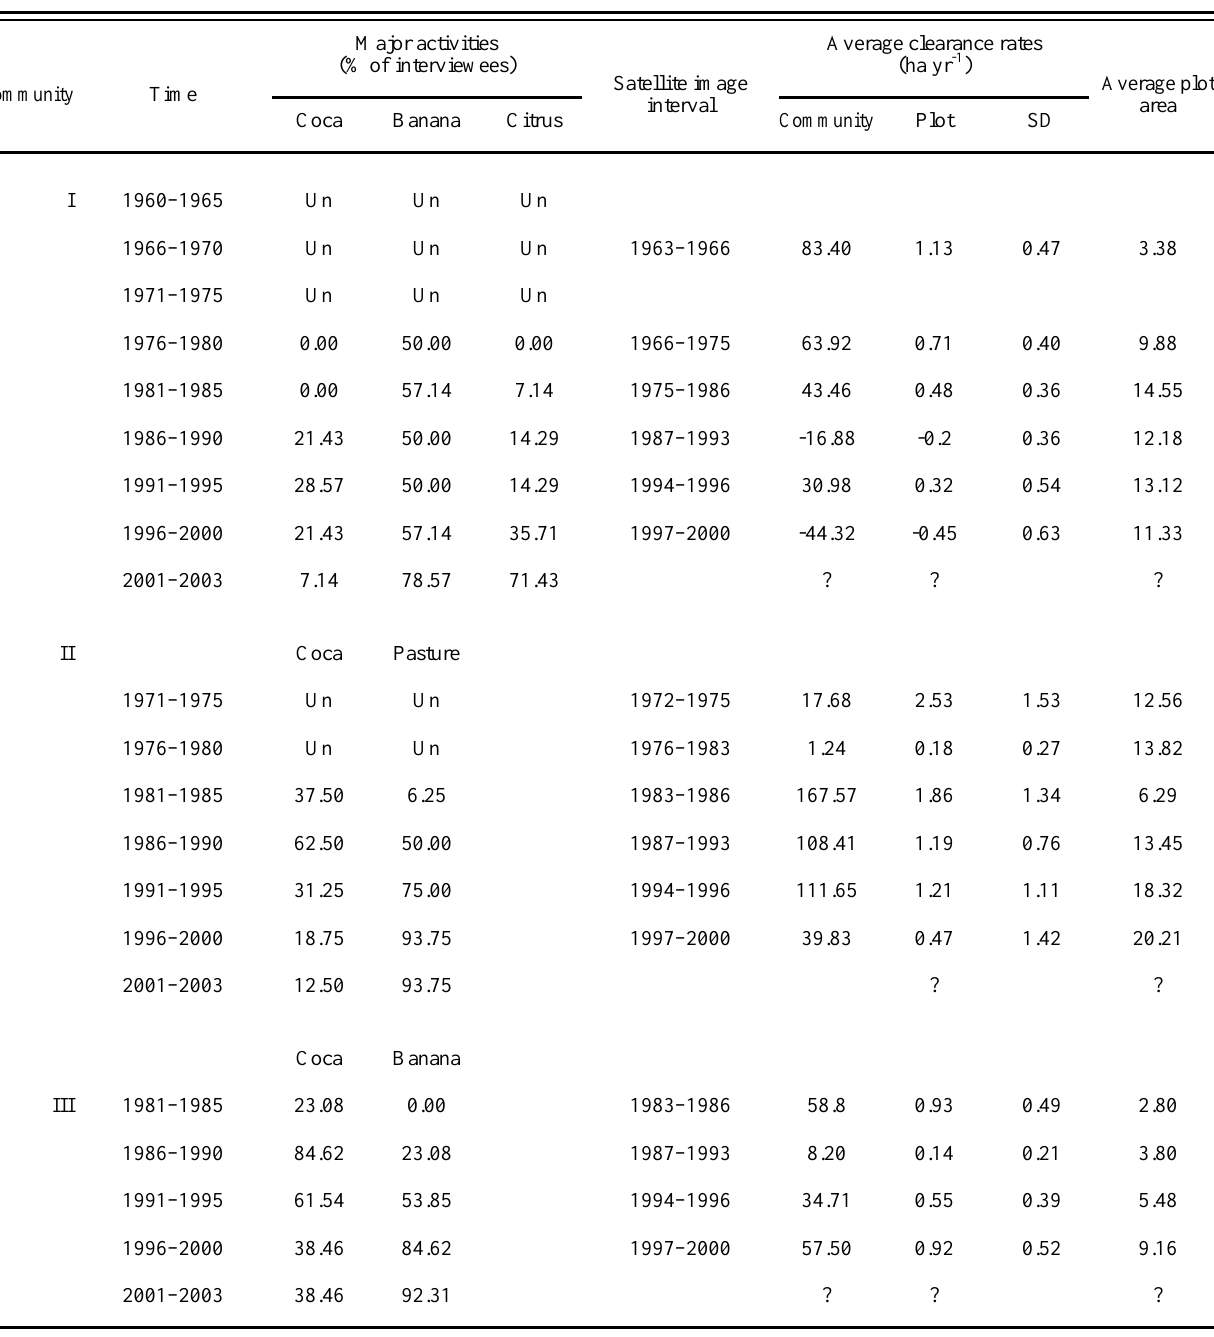
Table 4. Proportion of interviewed farmers cultivating bananas, citrus, and coca, or ranching in the three communities investigated; and forest clearance statistics for all land parcels in the same communities. Interview data have been aggregated in 5-year intervals and related to the inter-image statistics. un = denotes uncertain data due to less reliable recall by farmers interviewed.